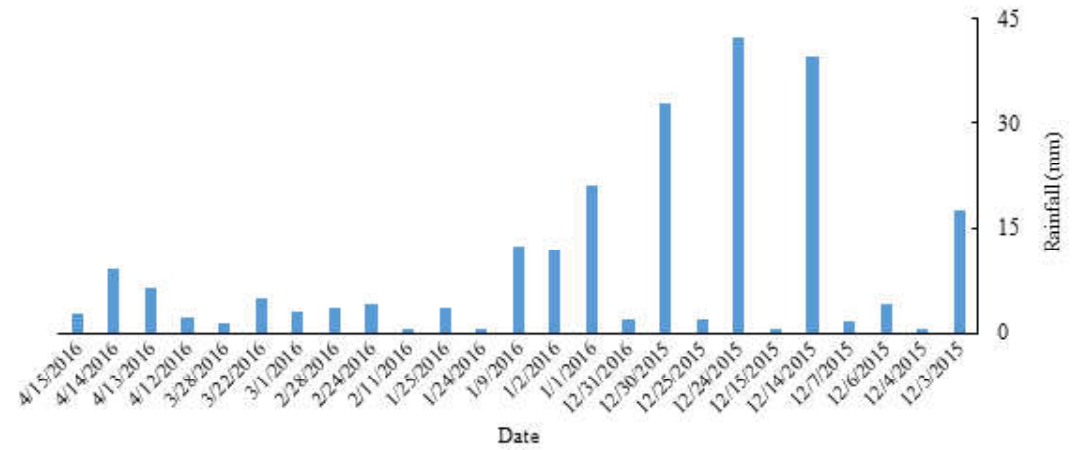
Fig. 2: The measured rainfall height in some of the recorded